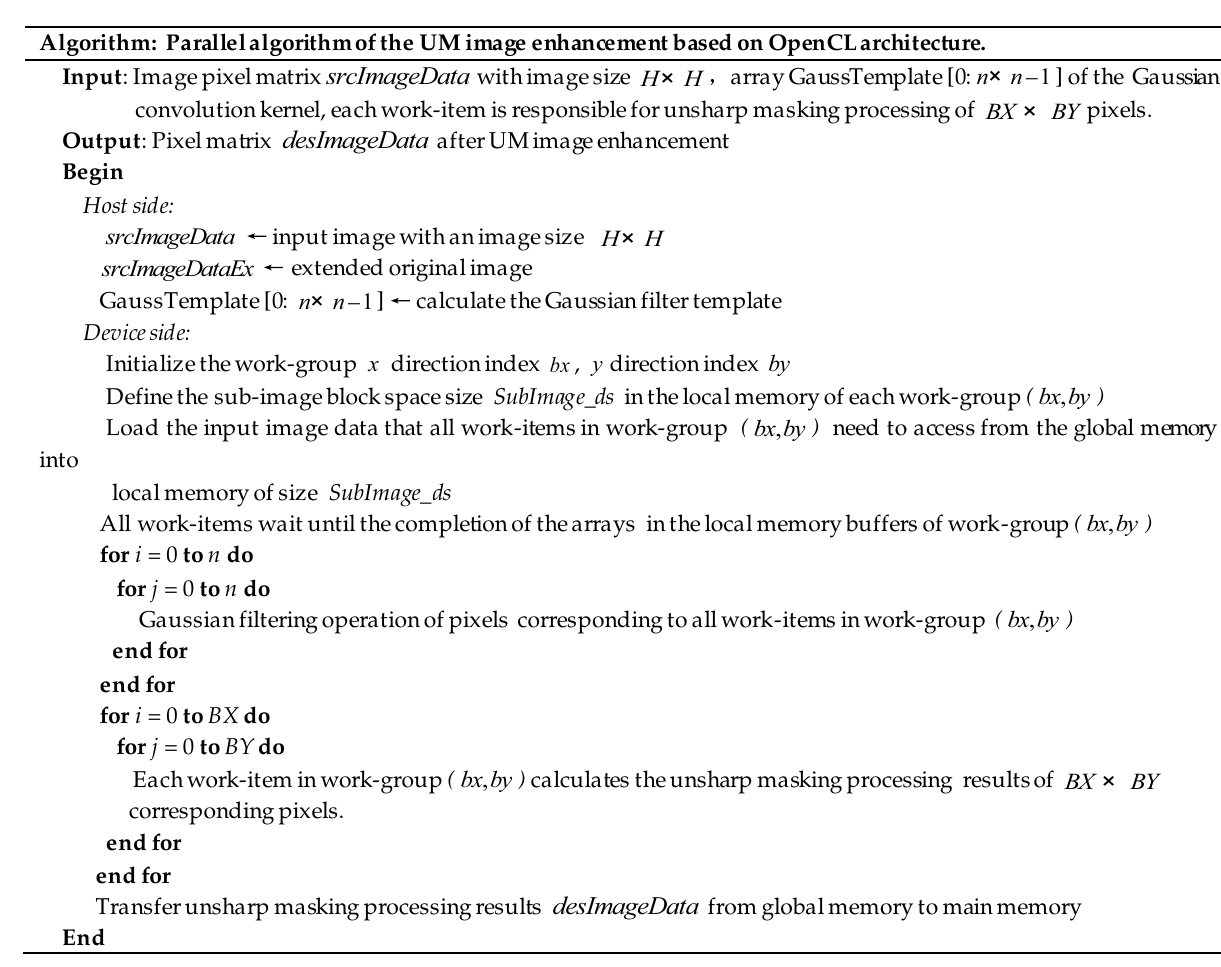
Algorithm: Parallel algorithm of the UM image enhancement based on OpenCL